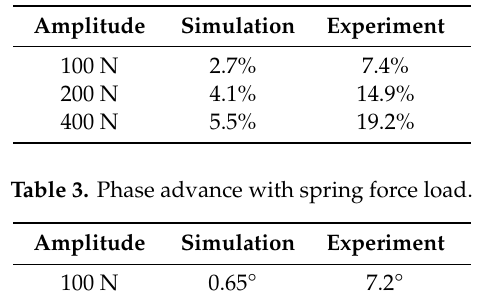
Figure 18. Experimental position outputs under rectangular forces. Table 2. Amplitude attenuation with spring force load.